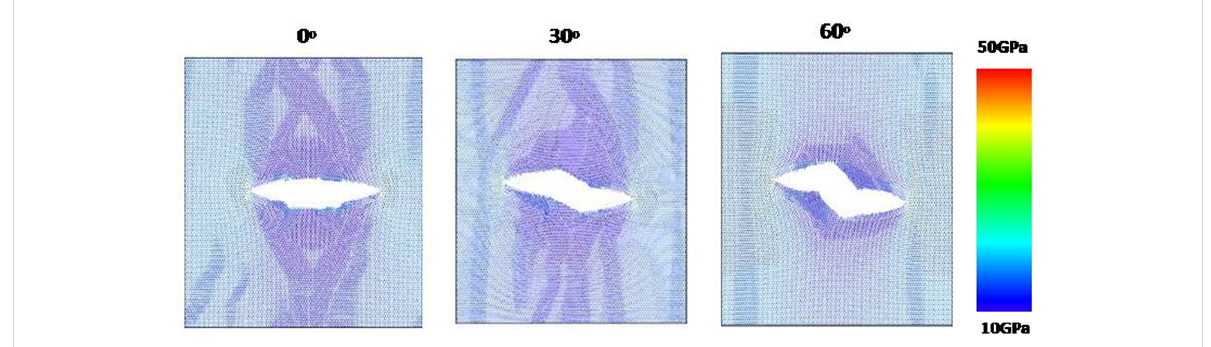
Figure 15: The von Mises stress distribution after crack extension for three crack